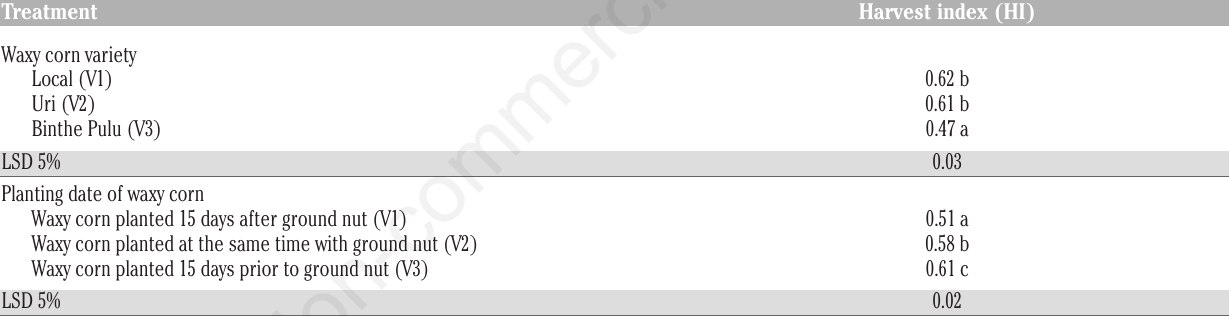
Table 3. Average harvest index of waxy corn for the 3 varieties and 3 planting dates at harvest time (110 hst). Treatment